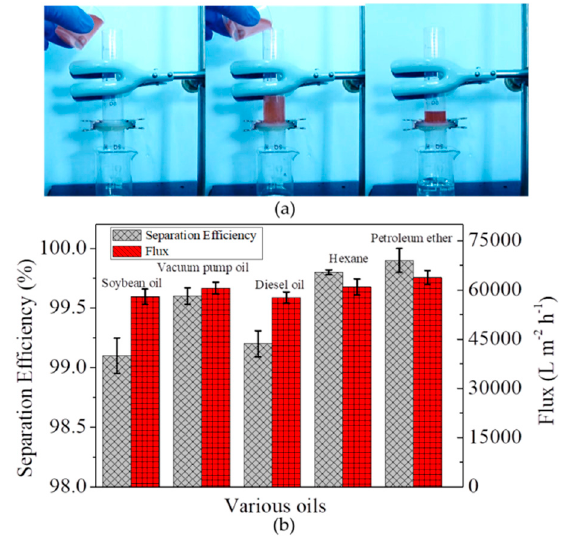
Figure 4. ( a ) Photos showing the separation process of hexane/water mixtures; ( b ) Separation efficiencies of microfiber filters towards five kinds of oils and corresponding fluxes at an altitude difference of 8 cm.